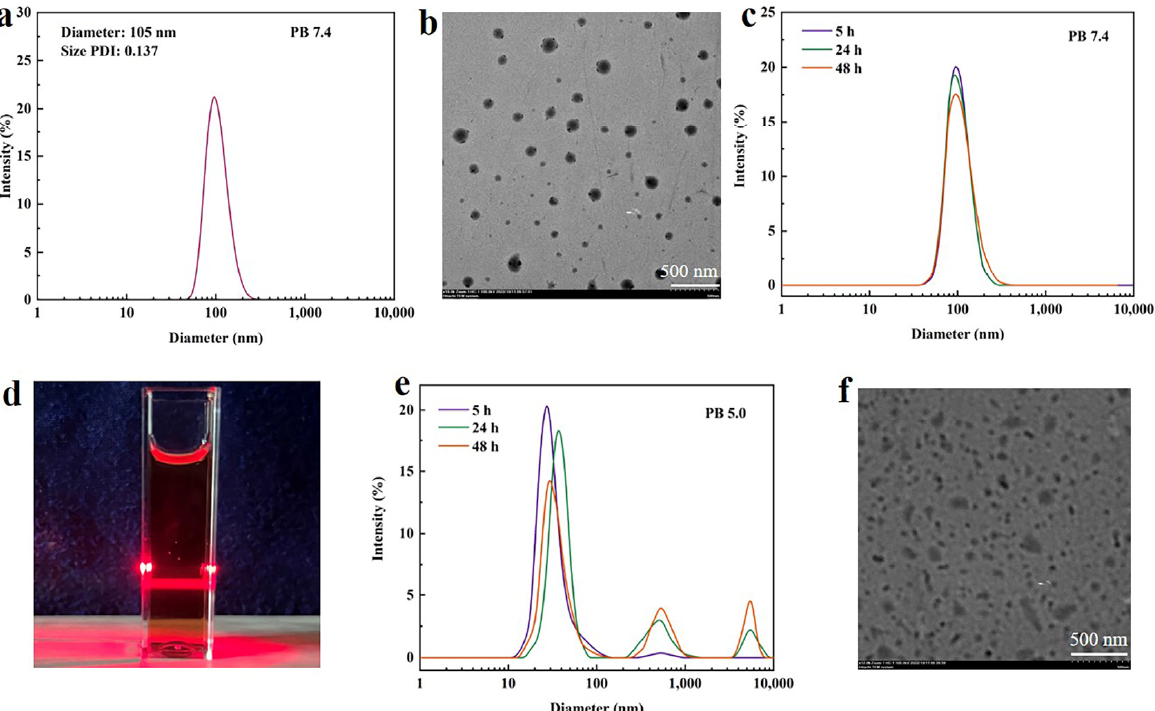
Figure 3. Size distribution and morphology of nanoparticles. ( a ) The size distribution and ( b ) TEM image of mAb-CD163-PNDPs in PB 7.4. ( c ) The size distribution of mAb-CD163-PNDPs in PB 7.4 within 48 h. ( d ) State of nanoparticles in PB 7.4. ( e ) The size distribution and ( f ) TEM image of mAb-CD163-PNDPs within 48 h in PB 5.0 (Concentration: 0.5 mg mL − 1 ).